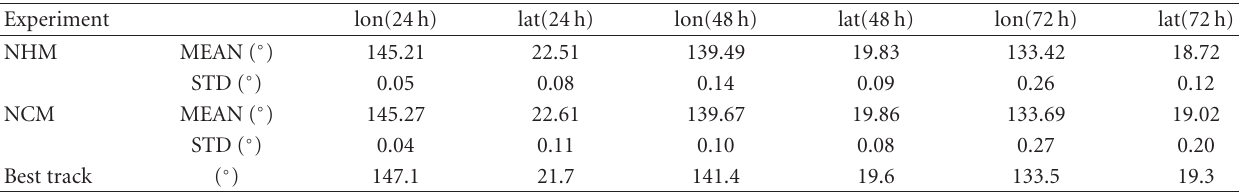
Table 2: Mean longitude and latitude and standard deviations of the predicted position every 24 h and best-track longitude and latitude.